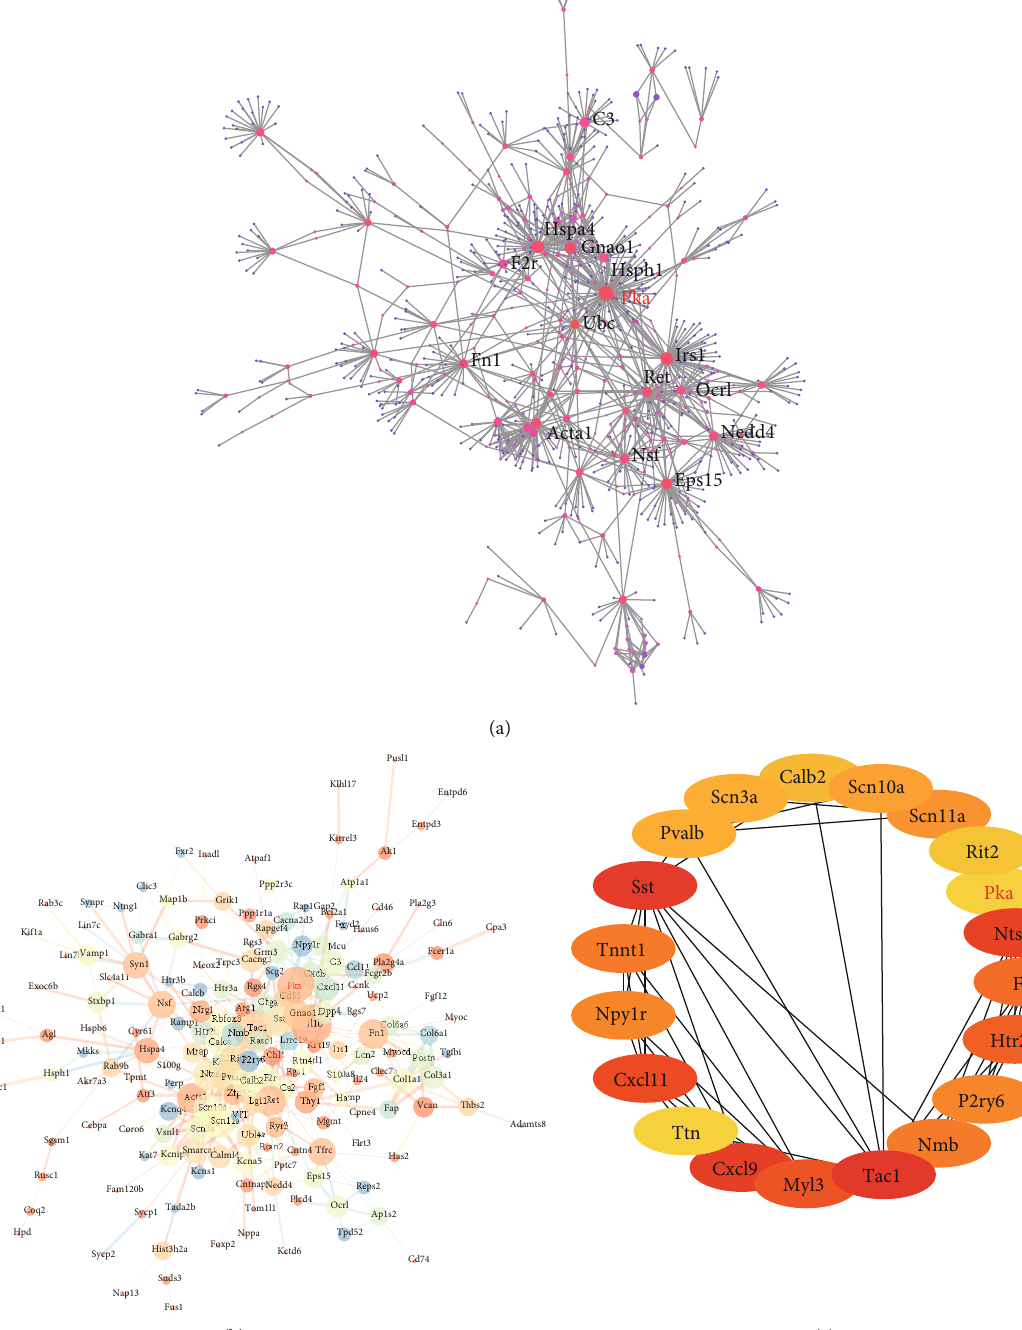
Figure 3: PPI network analysis and identi fi cation of hub genes. (a) PPI network based on the NetworkAnalyst database. (b) PPI network based on the STRING database. The node size indicates the clustering coe ffi cient, the node color indicates the representation degree, the line thickness indicates the comprehensive score, and the line color indicates coexpression. (c) Schematic diagram of the hub genes. Red, brown, and yellow indicate a high, low, and intermediate enrichment score,